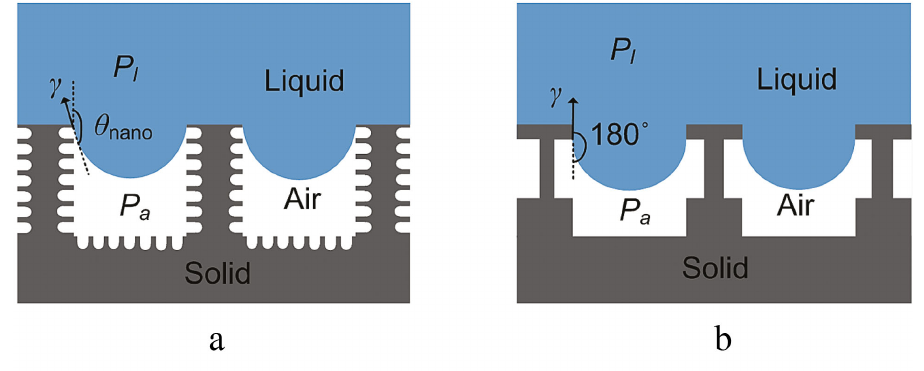
Figure 13. ( a ) Nanostructures on the sidewall; ( b ) re-entrant structure. From Lee and Kim